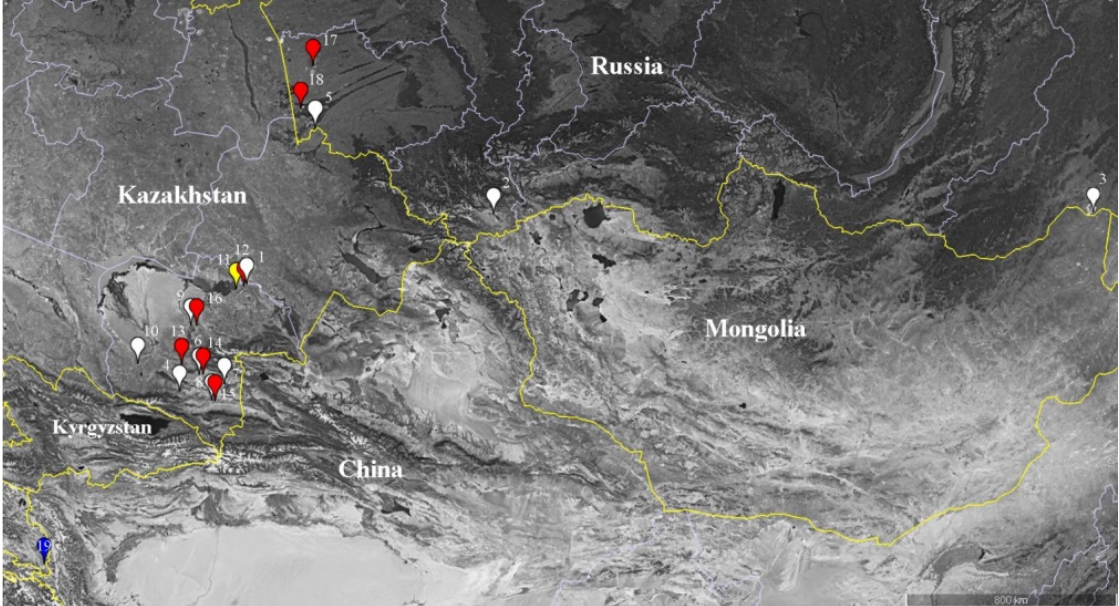
Figure 7. The map of sampling sites of species from the genus Nitraria . White color, N. sibirica ; red color, N. schoberi ; yellow color, N. komarovii ; and blue color, N. pamirica